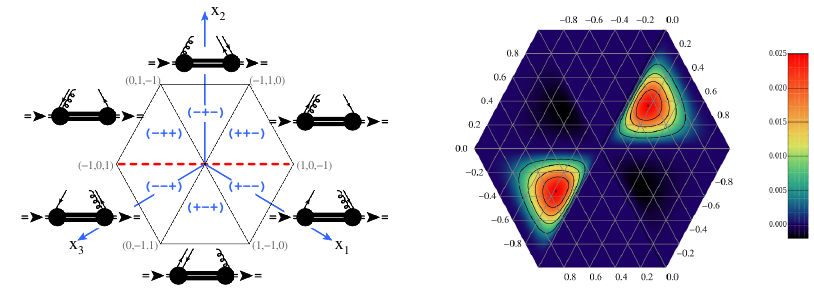
Figure 1. Domain interpretation (left) and the light-front wave function overlap model [21] (right) for the twist-three u -quark-antiquark-gluon correlation function in the proton.